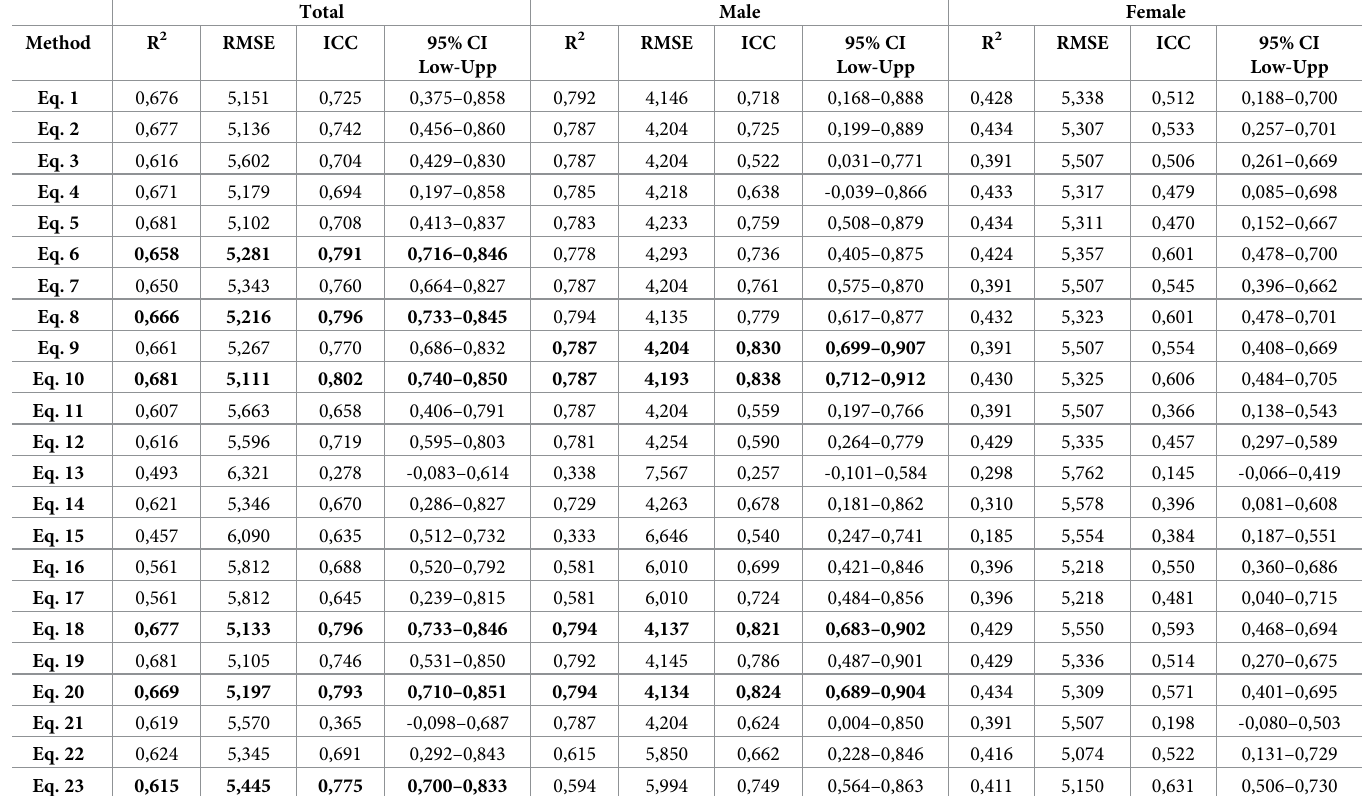
Table 4. Analysis of concordance of observed and estimated height of elderly living in nursing homes and stratified by sex, Brazil,